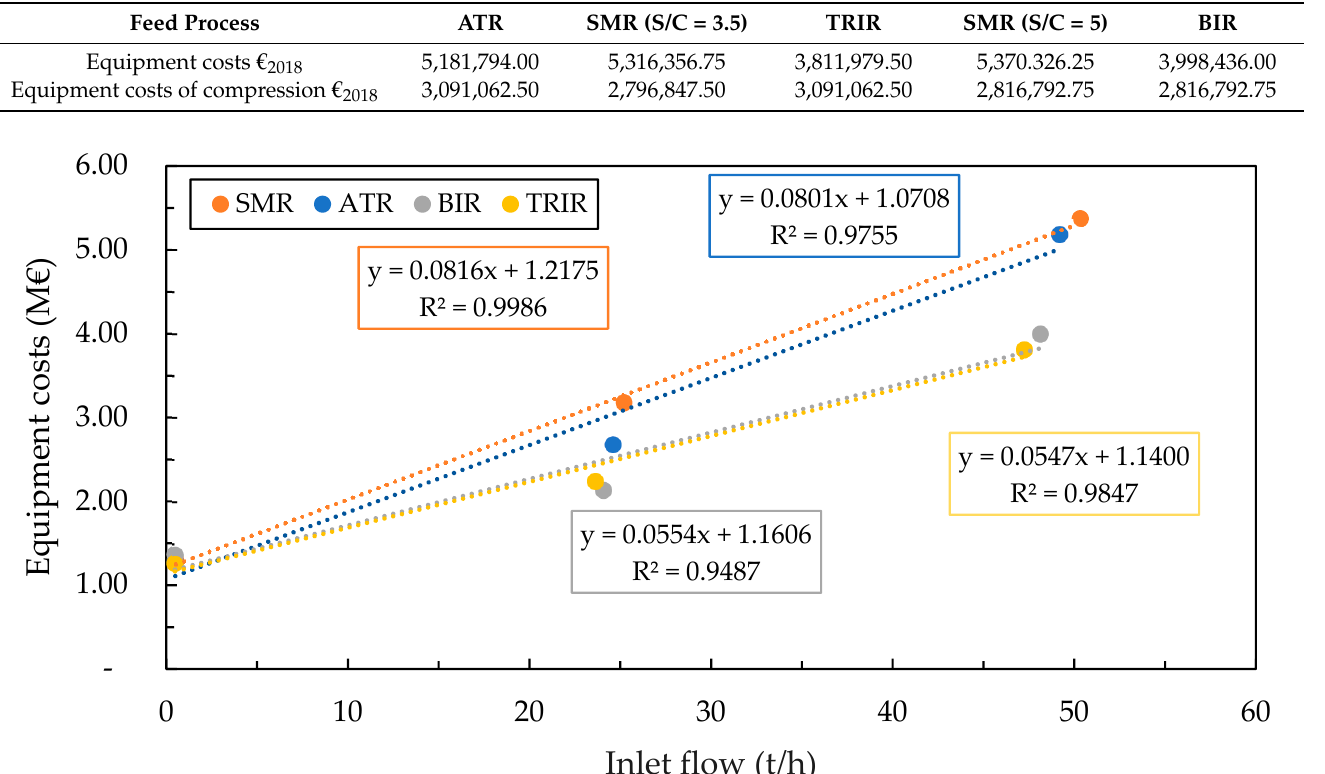
Table 13. Utilities and raw materials demand for Selexol process with different feed processes. ATR SMR (S/C = 3.5) TRIR SMR (S/C = 5) BIR Electricity (MW)